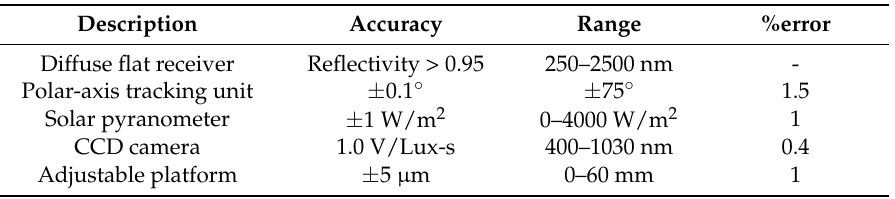
Table 1. Accuracies and errors for measurement instruments.